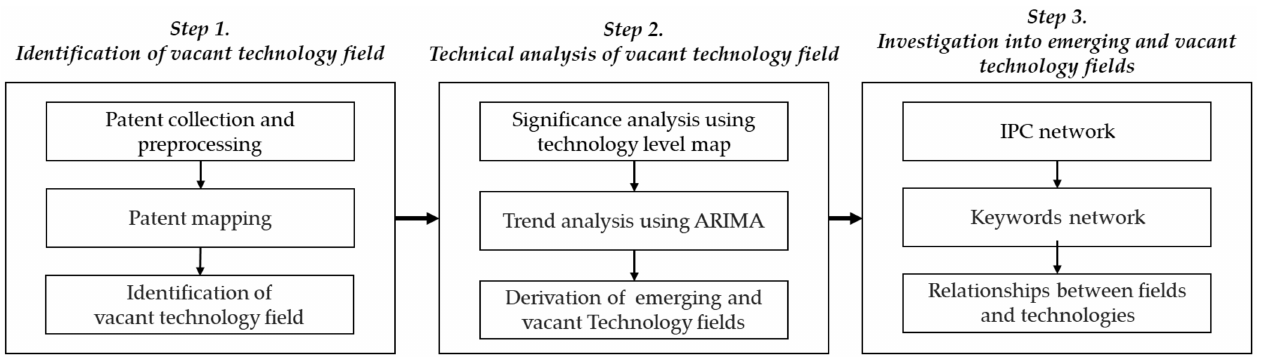
Figure 1. Overall